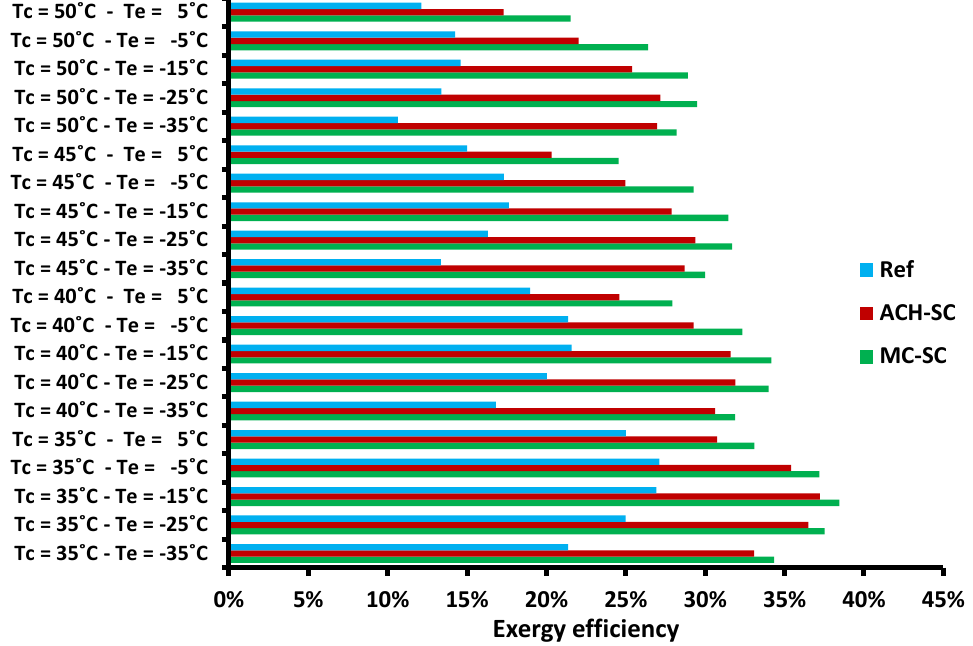
Figure 19. Comparison of the exergy efficiency for the three systems and in all the optimized cases.